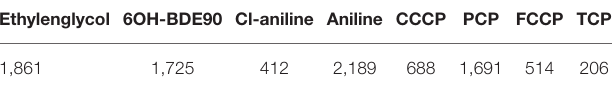
TABLE 6 | Number of genes that are significant gene regulation (|M| > 2 and p adj < 0.1) in microarray experiment